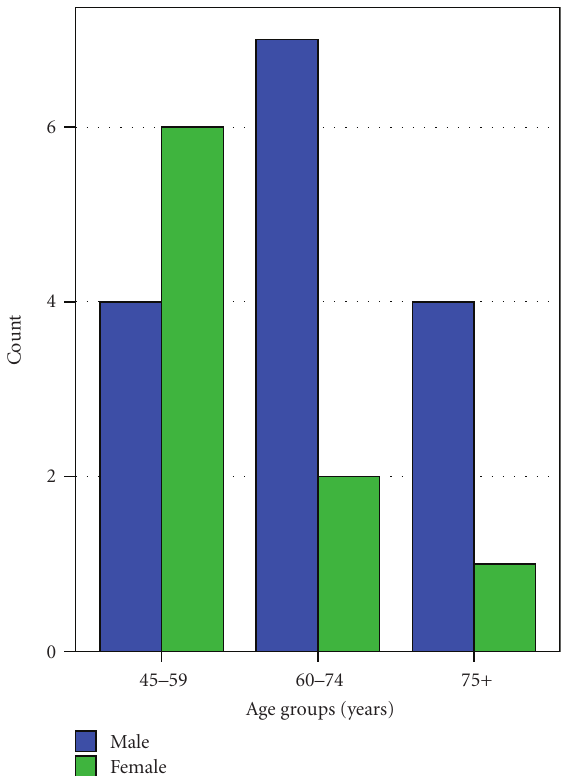
Figure 2: Age of the patients at the time of first basal cell carcinoma diagnosis.